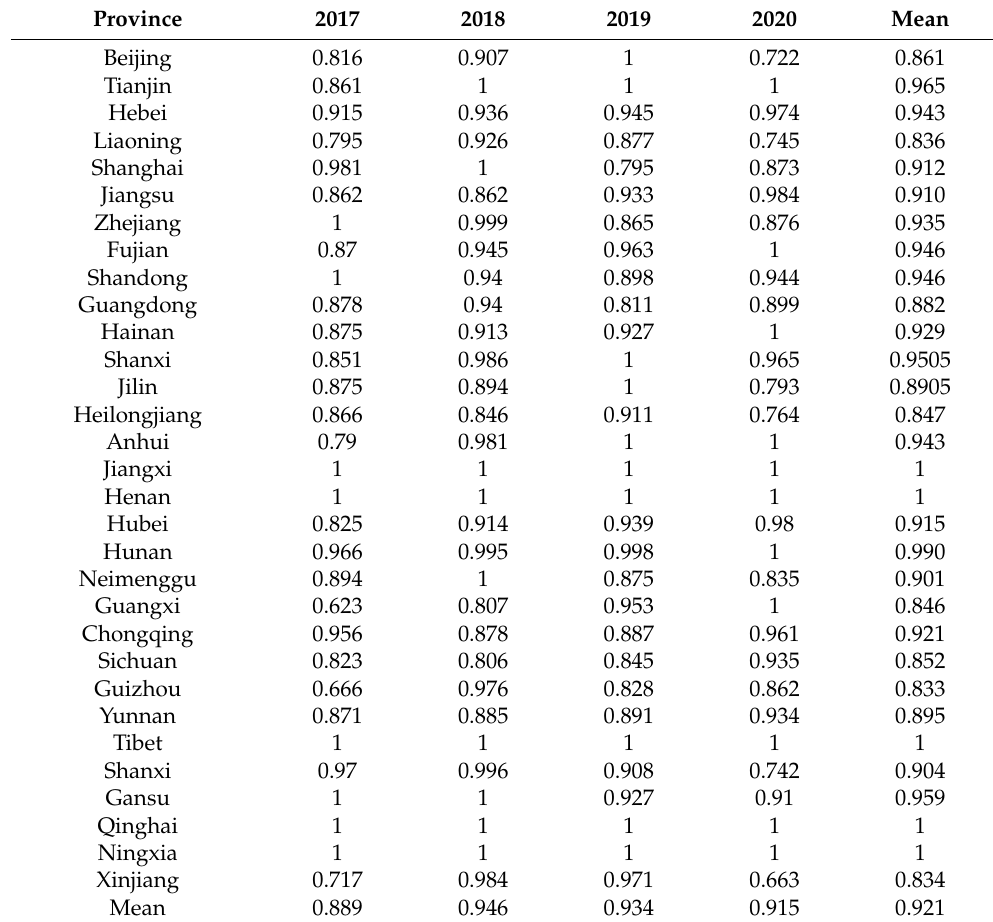
Table 4. Efficiency of the basic medical insurance funds in China, from